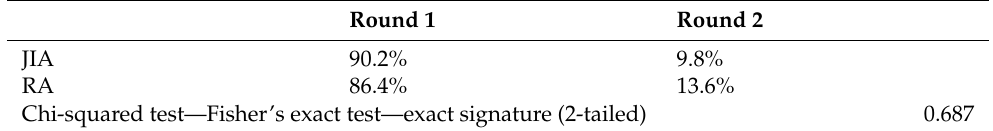
Table 10. Number of